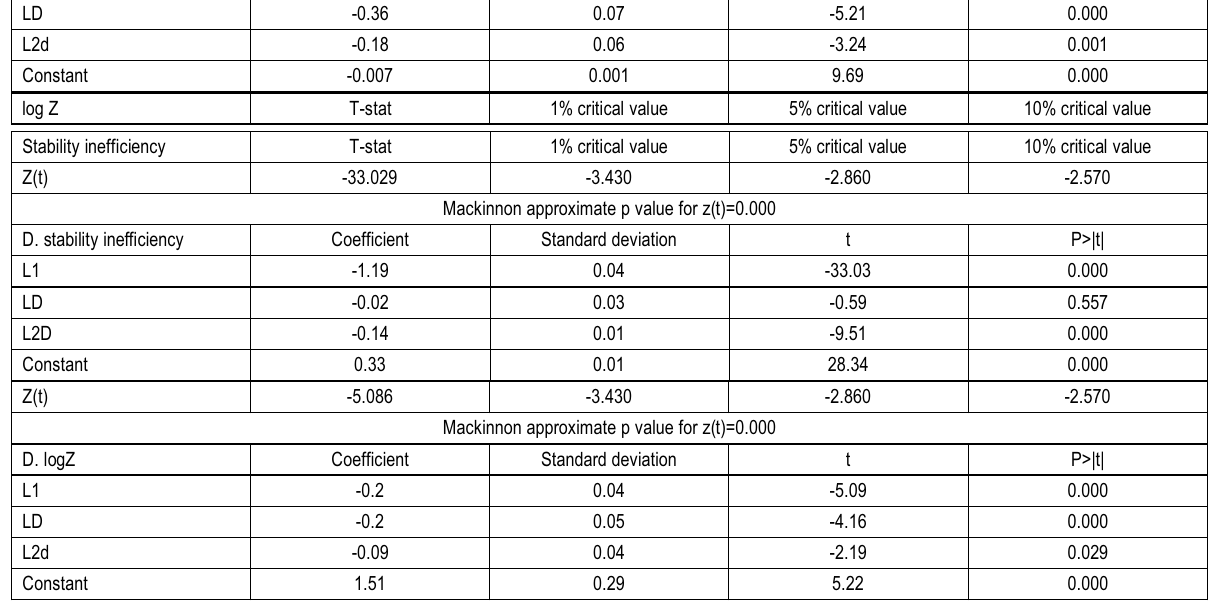
Table 4 Empirical results of the impact of insolvency risk on bank profitability